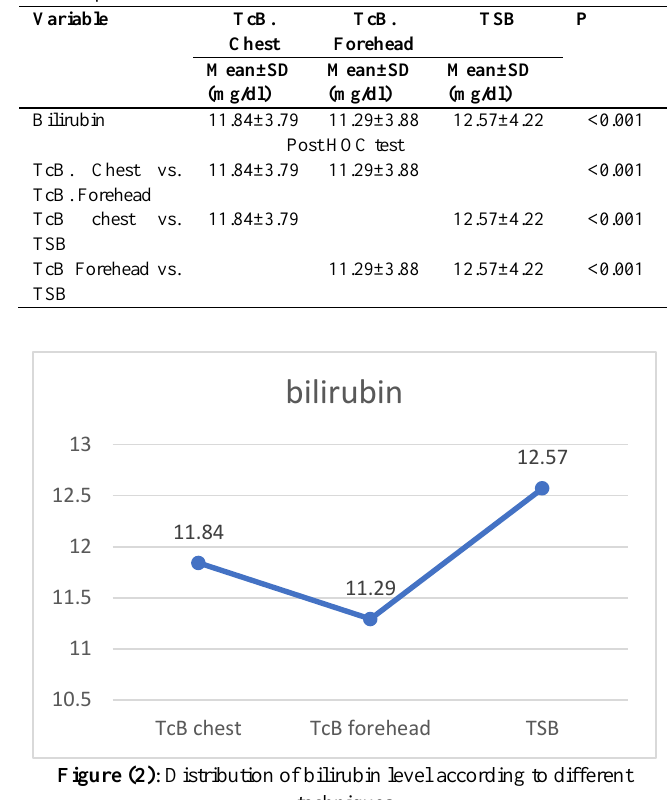
Table (5): Distribution of bilirubin level according to different techniques.